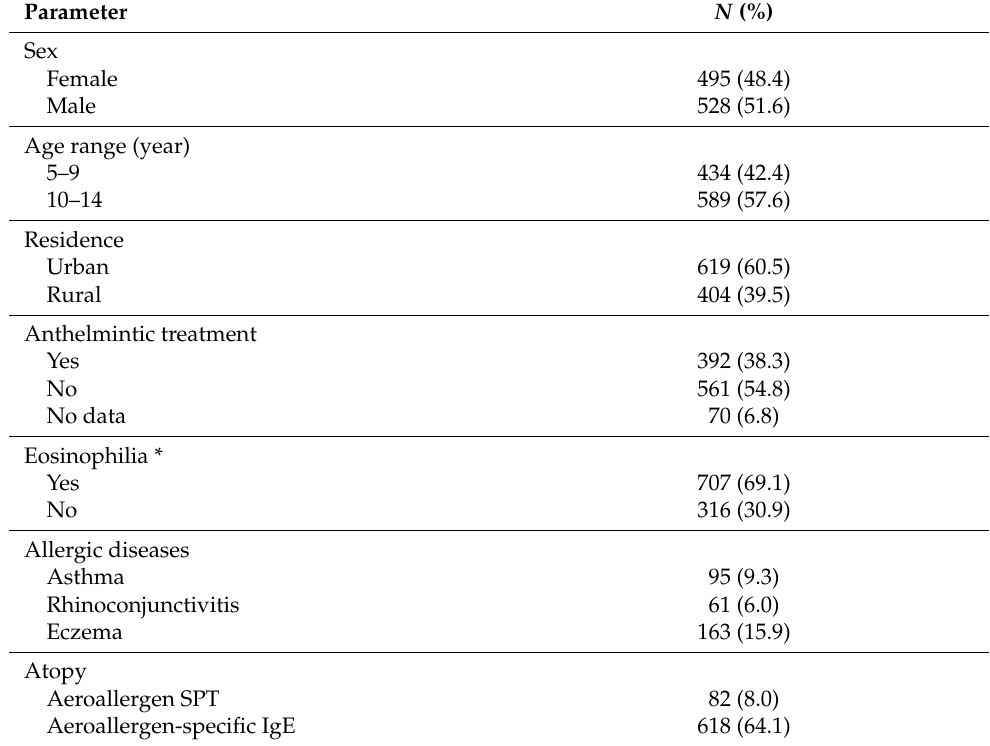
Table 1. Sociodemographic characteristics of study sample of 1023